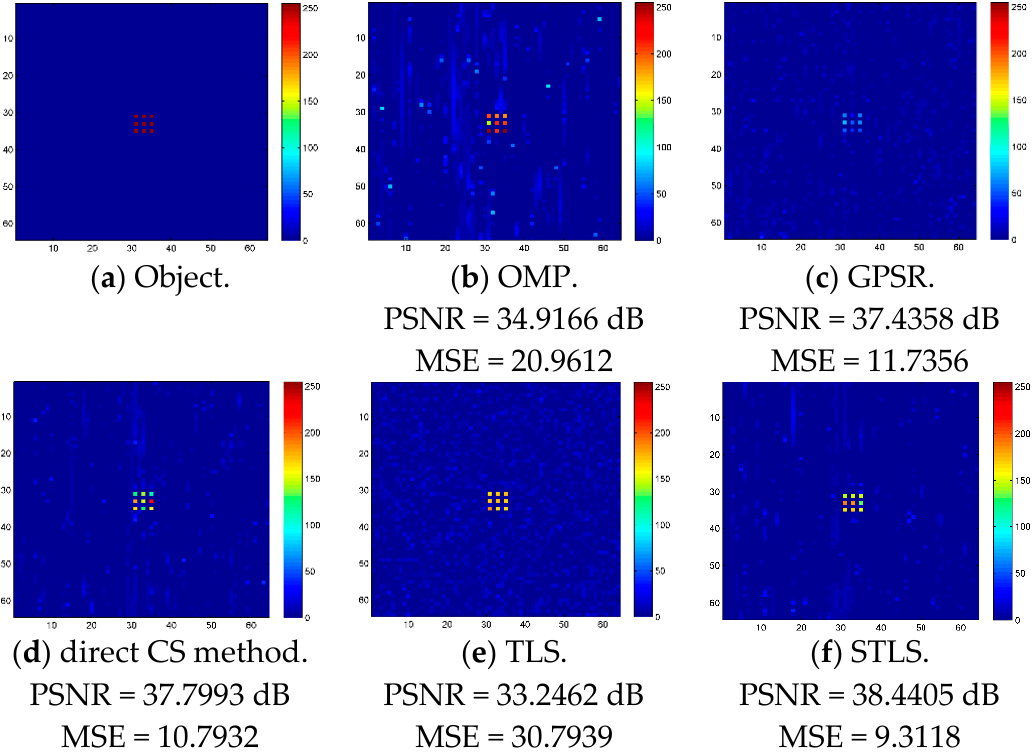
Figure 3. Reconstruction results of object with OMP, GPSR, Method proposed in [19], STLS (300 samples), and TLS (4500 samples). ( a ) Original object, ( b ) OMP result, ( c ) GPSR result, ( d ) Method proposed in [19], ( e ) TLS result and ( f ) STLS result.